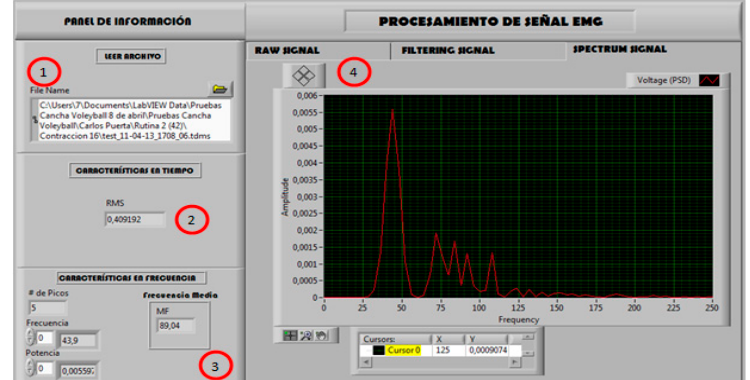
Figure 5. Front panel of the stage of digital processing and extraction of characteristics of the EMG signal.